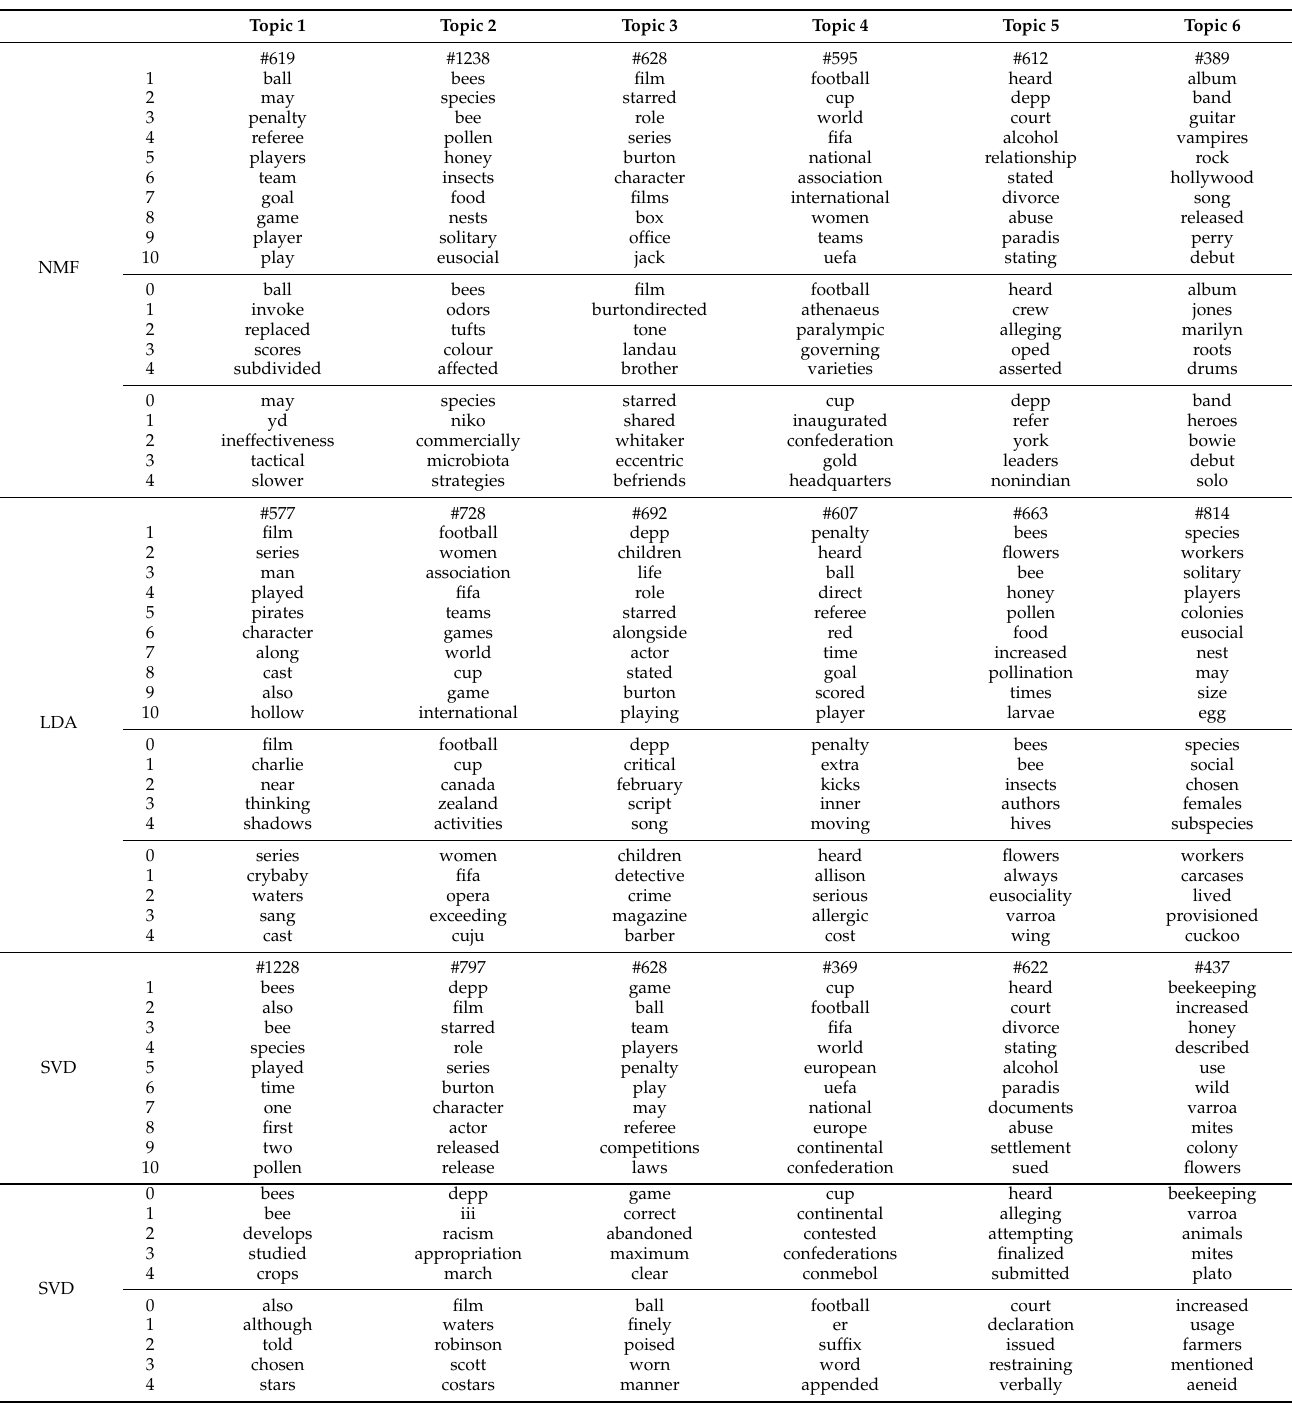
Table A1. For each evaluated matrix factorization method we display the top 10 words for each topic and the five most similar words based on cosine similarity for the two top words from each